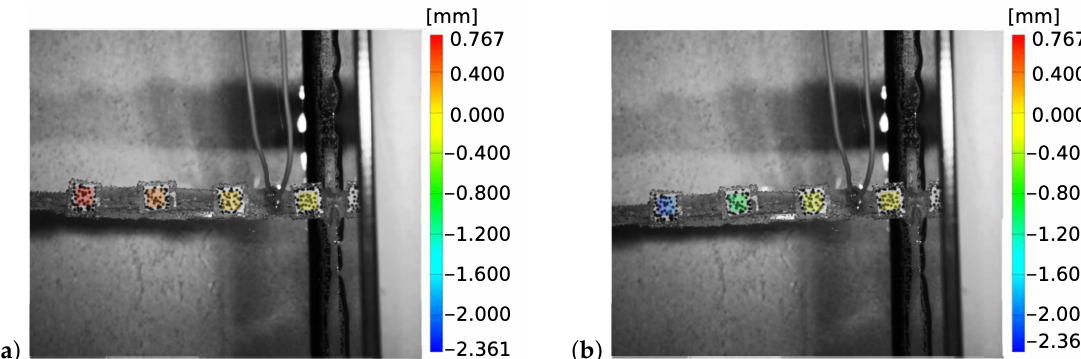
Figure 10. Recorded images of the DIC measurement together with the detected displacement information in y-direction. ( a ) Exemplary for the robot near its initial state ( b ) for a deflected